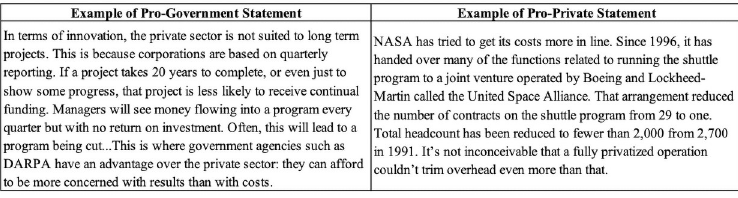
Fig 2. Examples of pro-government and pro-private investment in space statements utilized in experimental treatments. Individuals were randomly assigned to receive either four statements in support of government investment in space (left panel) or four statements in support of private investment in space (right panel).